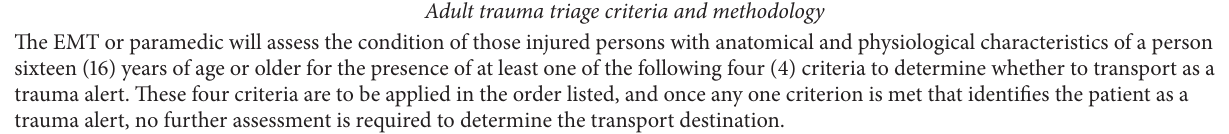
Table 2: 64J-2.004 adult trauma scorecard methodology.